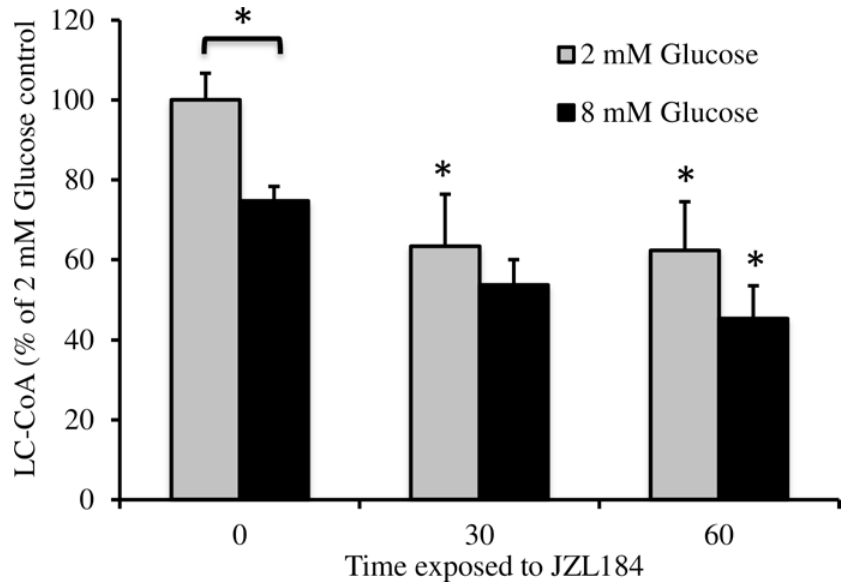
Fig 6. Significant reduction in total LC-CoA following acute treatment of INS-1 cells with JZL184. Cells were exposed to JZL184 at both basal and stimulatory glucose and LC-CoA was measured as described in the methods (n = 3). Error bars represent S.E. from independent experiments ( * , p <